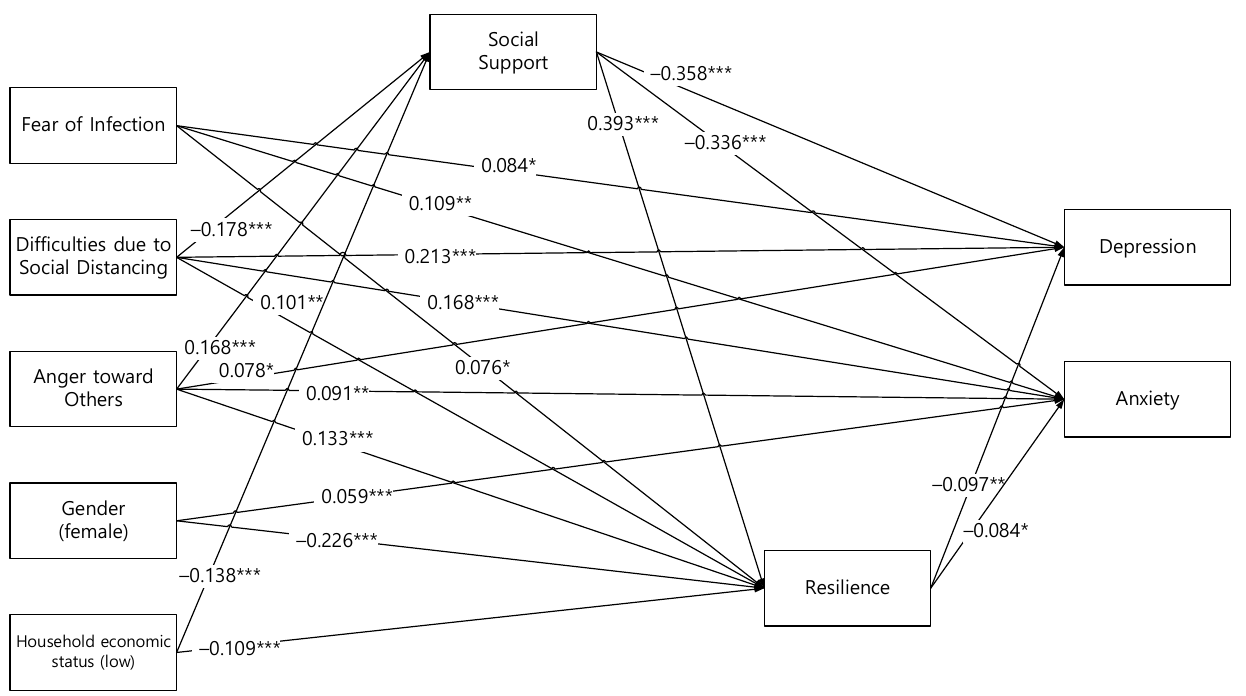
Figure 2. Final path diagram of depression and anxiety among young adults. * p < 0.05; ** p < 0.01; *** p < 0.001. Standardized coefficients are presented. Table 3. Direct, indirect, and total effects of the final modified